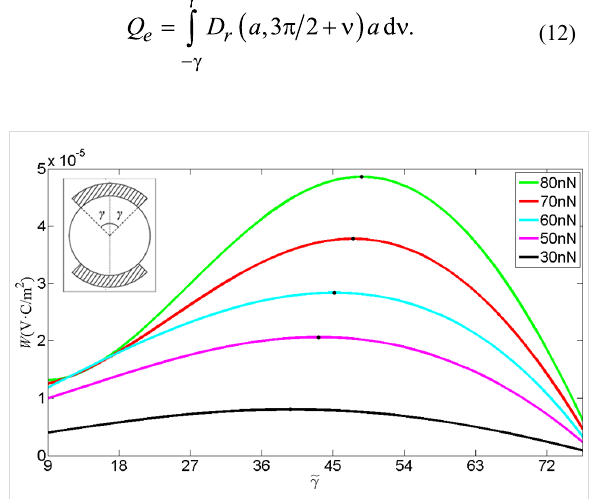
Figure 8: W as a function of the electrode configuration for different end